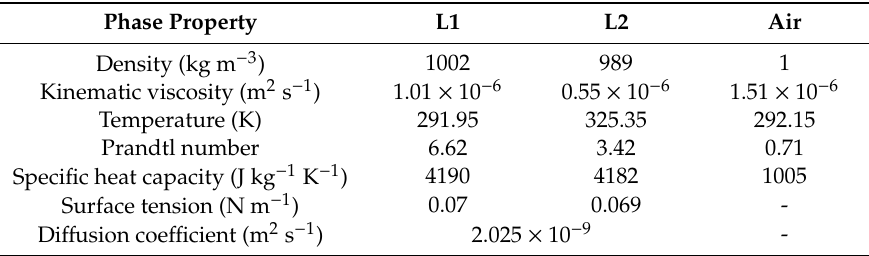
Table 2. Transport properties for the three fluid phases.